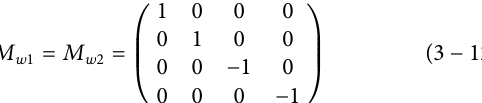
FIGURE 9 | The change trend of intensity and DOP of backward scattering light in underwater environment. (A) The changes trend of intensity of backward scattering. (B) The change trend of Dop of backward